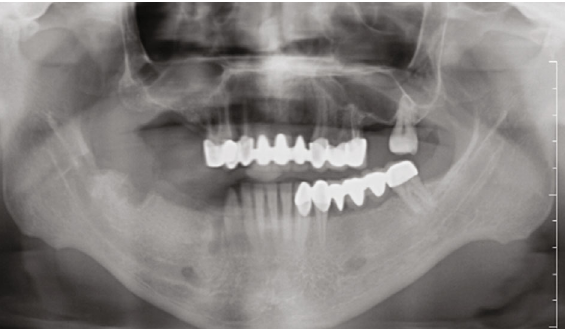
Figure 6: Postoperative orthopantomograph of the patient.